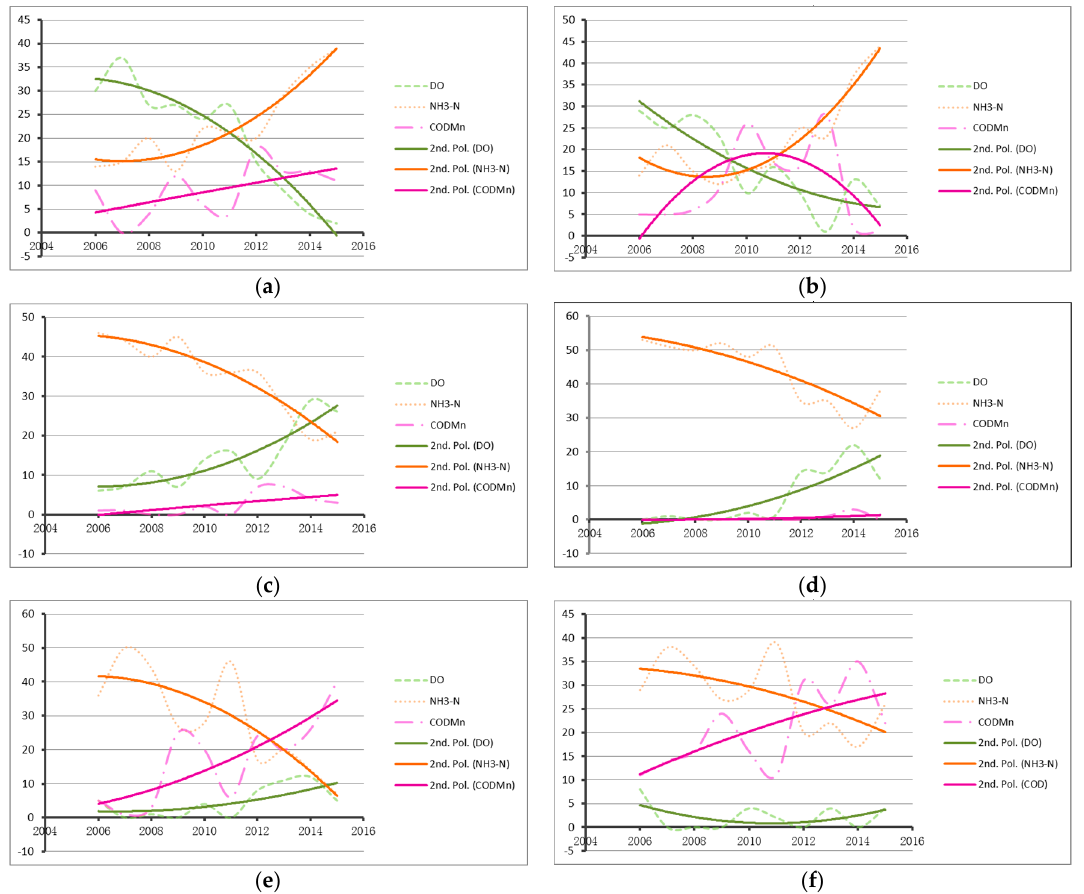
Figure 6. The annual pattern of major pollutant change in a few sections of the Yangtze River. ( a ) the First Minjiang Bridge; ( b ) Linshan; ( c ) Xin Port; ( d ) Jishui Port; ( e ) Hexi Water Plant; ( f ) Hama Stone.